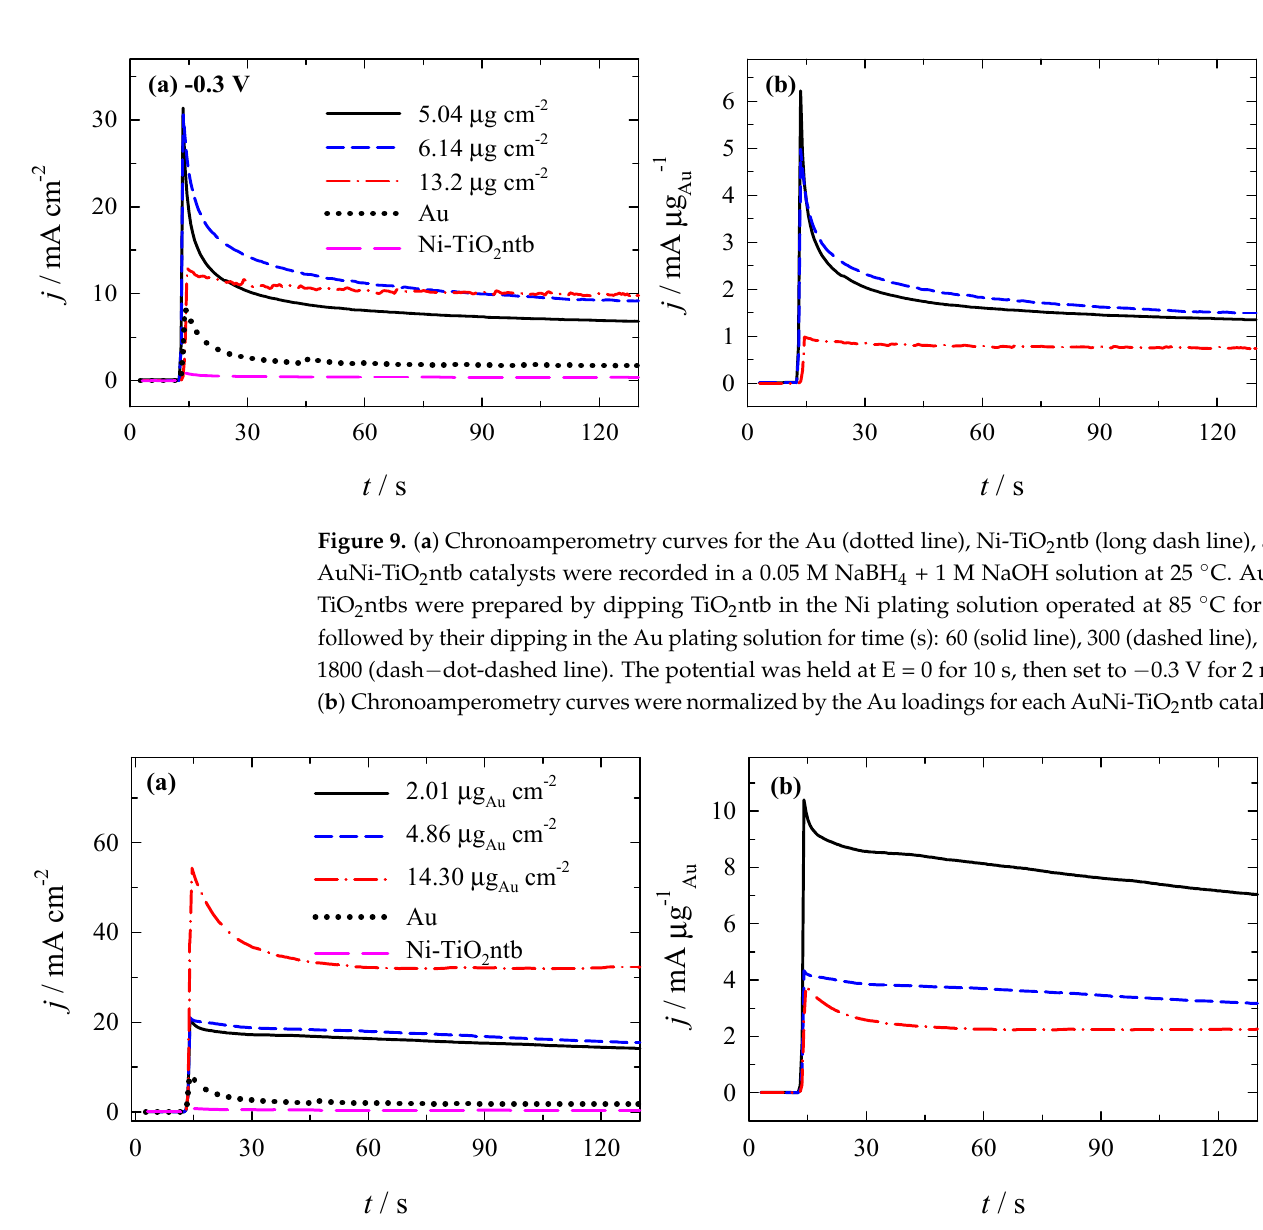
Figure 10. ( a ) Chronoamperometry curves of the Au (dotted line), Ni-TiO 2 ntb (long dash line), and AuNi-TiO 2 ntb catalysts were recorded in a 0.05 M NaBH 4 + 1 M NaOH solution at 25 °C. AuNi-TiO 2 ntbs were prepared by dipping TiO 2 ntb in the Ni plating solution operated at 85 °C for 20 s, followed by their dipping in the Au plating solution for time (s): 10 (solid line), 20 (dashed line), and 60 (dash − dot-dashed line). The potential was held at E = 0 for 10 s, then set to − 0.3 V for 2 min. ( b ) Chronoamperometry curves were normalized by the Au loadings for each AuNi-TiO 2 ntb catalyst.